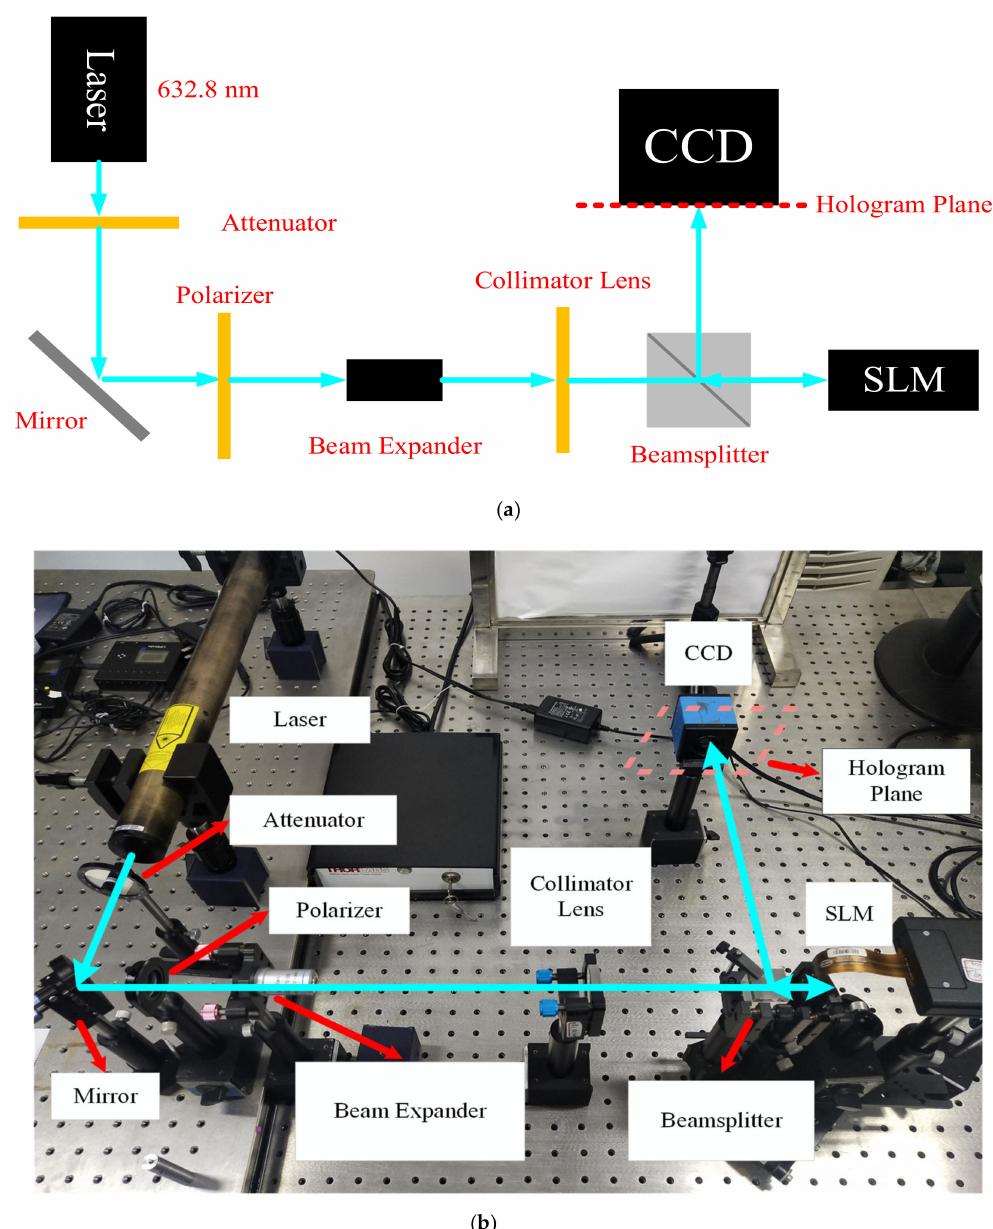
Figure 8. Schematic diagram of the optical path used for optical reconstruction and the actual optical device. ( a ) shows the schematic diagram of the optical path used for optical reconstruction; ( b ) shows the optical path system built with the actual experimental setup for optical